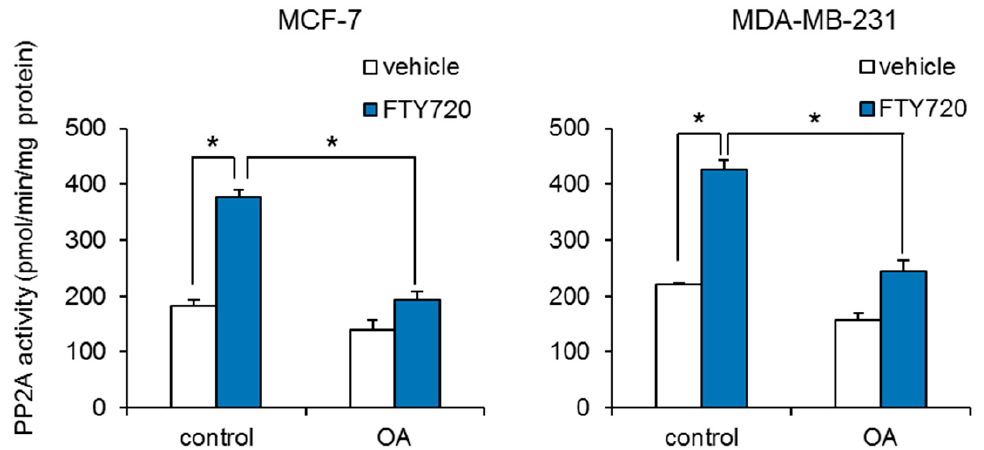
Figure 2. Effect of FTY720 on stem cell marker genes in breast CSCs. After treatment with FTY720 (3 µM) for 24 and 48 h, expression levels of stem cell marker genes in MCF-7 cells ( left ) and MDA-MB-231 cells ( right ) were measured by real-time RT-PCR. Data represent mean ± s.d. ( n = 3). * p < 0.05.